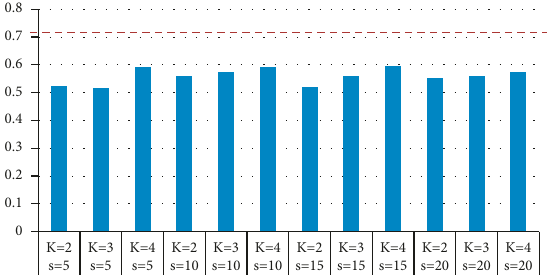
Figure 8: Sensitivity of CBCD on BAC with a threshold 0.01.